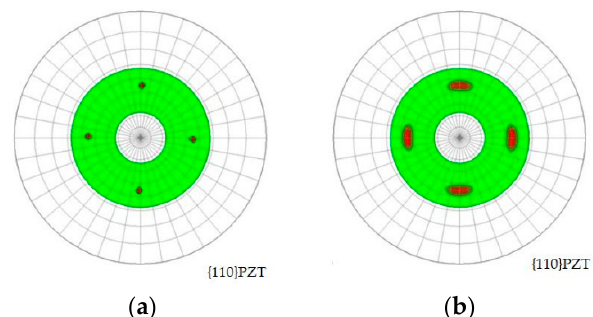
Figure 5. In-plane epitaxial relationships of ( a ) monocrystalline and ( b ) fibered-epitaxial films by pole figures.